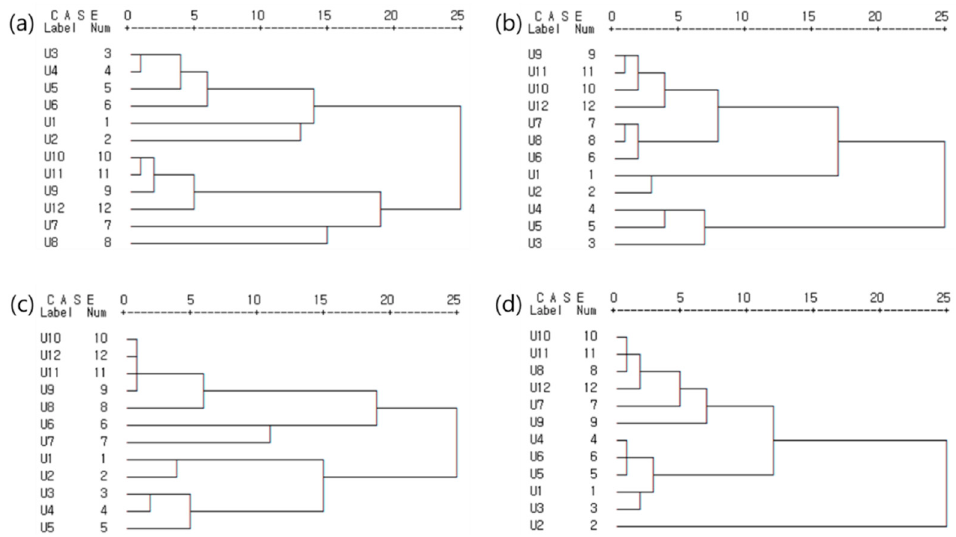
Figure 9. Dendrograms of the environmental parameters of 10 sampling sites in the Taehwa River estuary, Korea. ( a ) February, ( b ) May, ( c ) August, and ( d ) November.